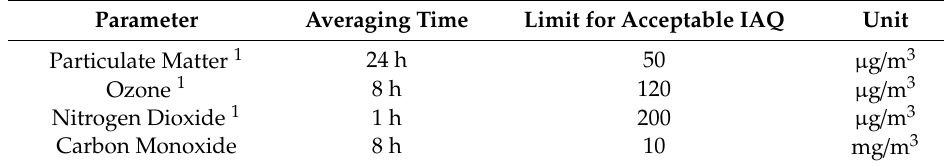
Table 4. Maximum concentrations for specific indoor air quality (IAQ) contaminants [99]. Parameter Averaging Time Limit for Acceptable